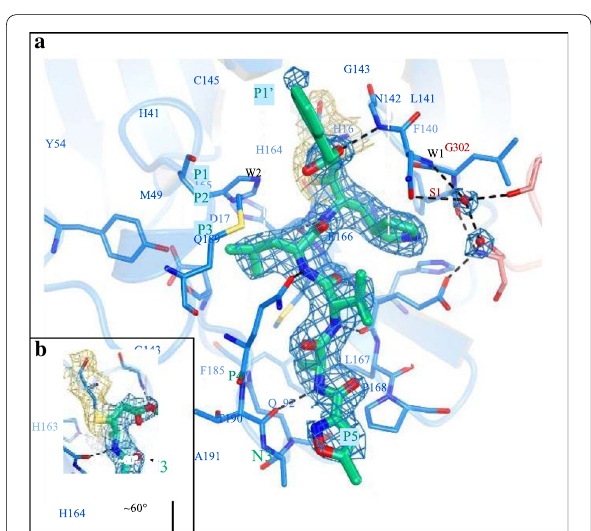
Fig. 3 a The substrate-binding pocket in considerable detail. The important residues that help compensate the binding pocket are represented by sticks, while the two hydrogen bonds (W1 and W2) are represented by circles spheres of red the P1, P1 ′ , P2, P3, P4, and P5 N3 sites are shown. Black dashed lines signify hydrogen bonding that enable to lock the inhibitor. Across the N3 molecule (blue mesh), C145 of protomer A (yellow mesh), and the two liquids, the 2Fo Fc density map scaled at 1.2 is illustrated (blue mesh). b The C-S covalent